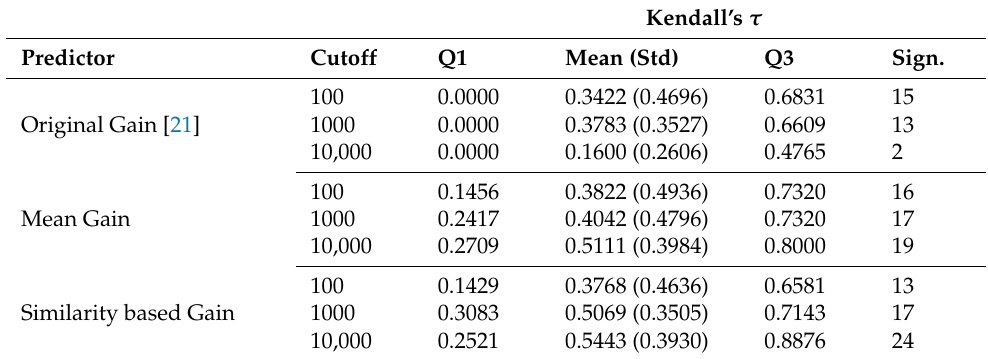
Table 4. Kendall’s τ correlation observed for the task of predicting the query formulation recall, using the similarity based approaches. In bolt, best mean score for each cutoff. Note that all the methods considered perform better than traditional predictors(cft Table 3). We also have a higher number of significant rankings compared to the one observed before.